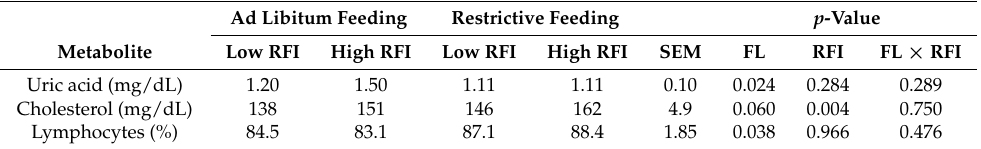
Table 4. Serum uric acid and cholesterol and proportion of lymphocytes in blood of low and high residual feed intake (RFI) broiler chickens fed either ad libitum or